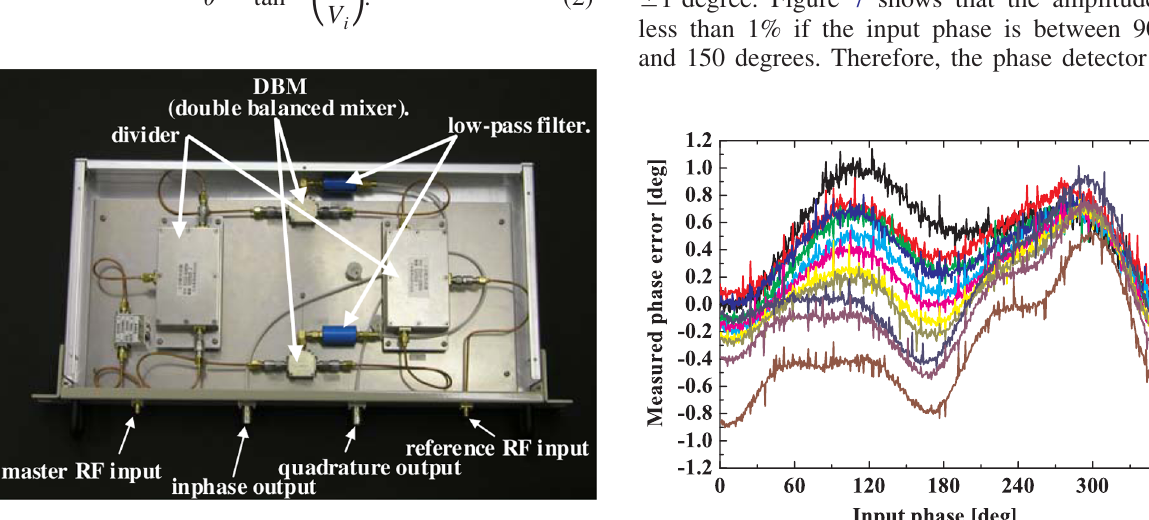
FIG. 6. (Color) Measured phase error with the DBM-based I/Q